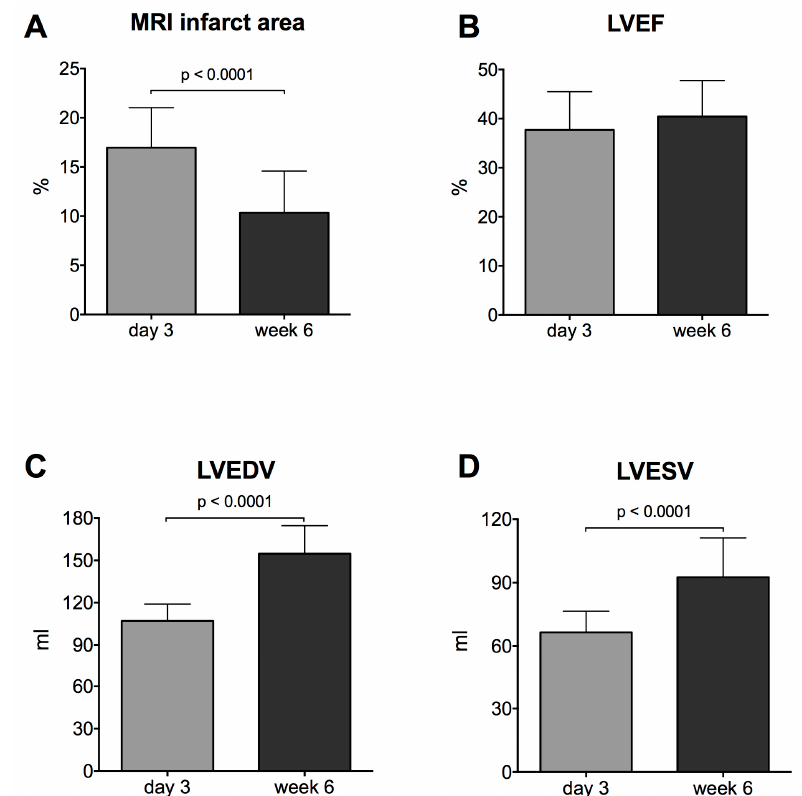
Figure 1. Infarct size ( A ), left ventricular ejection fraction (LVEF) ( B ), left ventricular end diastolic volume (LVEDV) ( C ) and left ventricular end systolic volume (LVESV) ( D ) 3 days and 6 weeks after acute myocardial infraction ( n = 24).